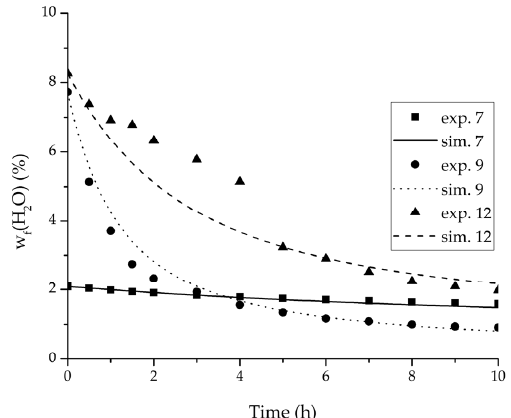
Figure 11. Experimental water mass fractions (feed) over time for three experiments used for the validation of the permeance function for ethyl acetate/water compared with the corresponding simulation result.